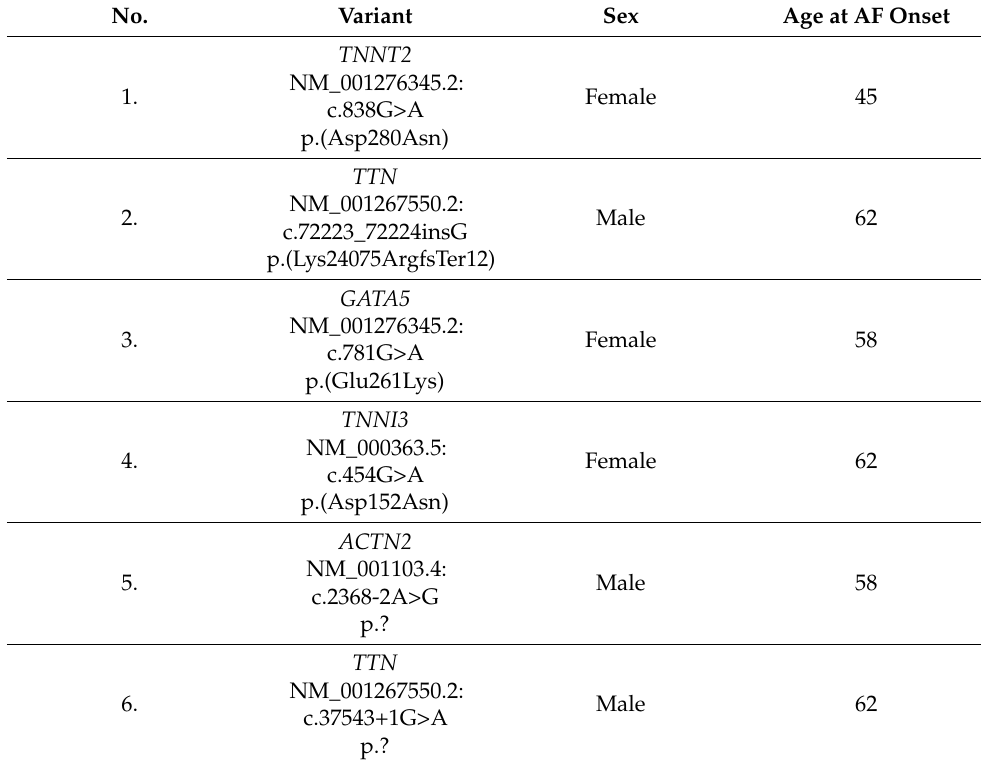
Table 2. P/LP variants and clinical data of 107 EOAF patients from the UK Biobank. No. Variant